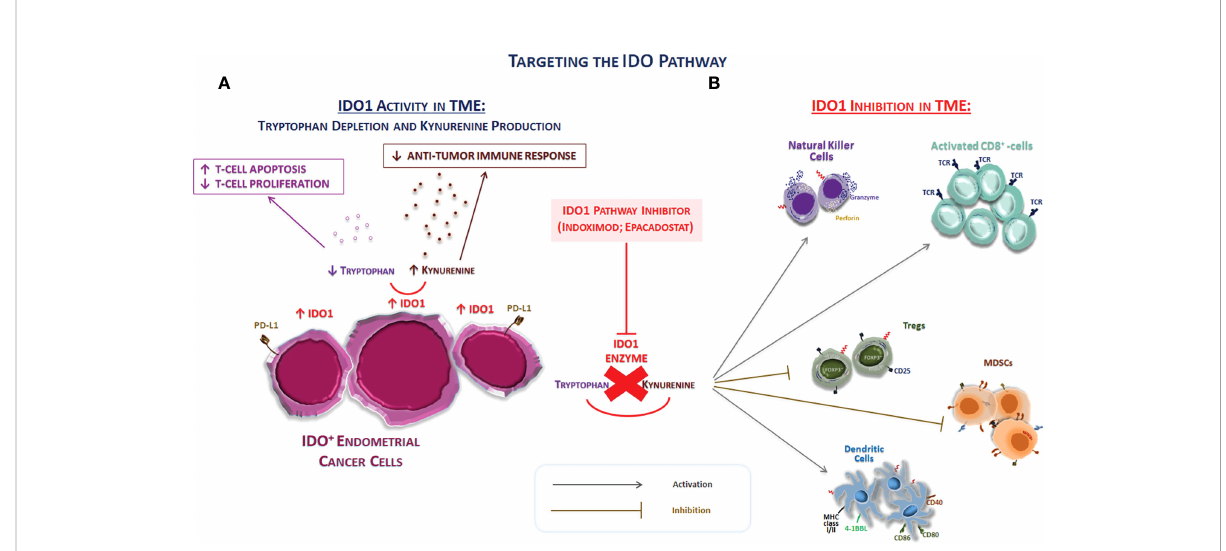
FIGURE 2 Targeting the IDO pathway. (A) The schematic representation of the effect of IDO1 on immune system cells of TME. IDO1 inhibits immune responses through several mechanisms, including the depletion of the essential amino acid tryptophan and the overproduction of kynurenine. The tryptophan depletion can inhibit T-cell proliferation arresting the cell progression cycle. In addition to the depletion of tryptophan, the accumulation of kynurenine exerts also immunosuppressive effects through the promotion of the differentiation of FOXP3 + T regs , the decrease in the immunogenicity of DCs, and the inhibition of T effector cell. Thus, IDO1 represents a driver of tumor-mediated suppression. (B) The IDO1 pathway inhibition directly acts on the modulation of both innate and adaptive immune system in TME. Thus, the IDO1 inhibition can potentially turn these “ cold ” tumors into “ hot ” tumors. Abbreviations: IDO1, indolamine 2,3-dioxygenase 1; MHC, major histocompatibility complex; MDSC, myeloid-derived suppressor cells; TCR, T-cell receptor; T regs , regulatory T